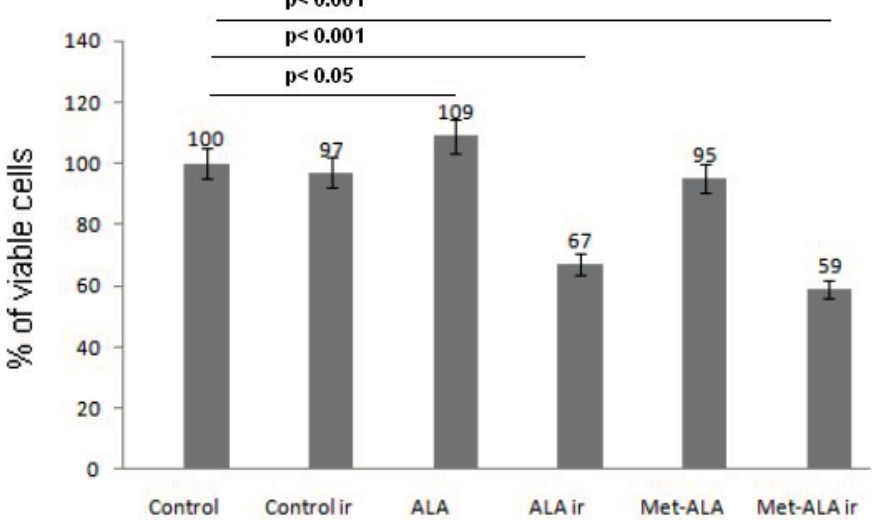
Figure 1. Percent of viable cells determined by the MTT assay. Photodynamic therapy by means of 5-aminolevulinic acid (5-ALA) or its methyl ester (met-ALA) decreased the viability of SW620 cells. Cells were treated with equal concentration of the above precursors for 4 h (5-ALA, Met-ALA) and then irradiated with 4.5 J/cm 2 at 630 ± 20 nm (ir, irradiation). Cell viability was measured after 24 h following irradiation. All data are the means in percent with 5% statistical error from three